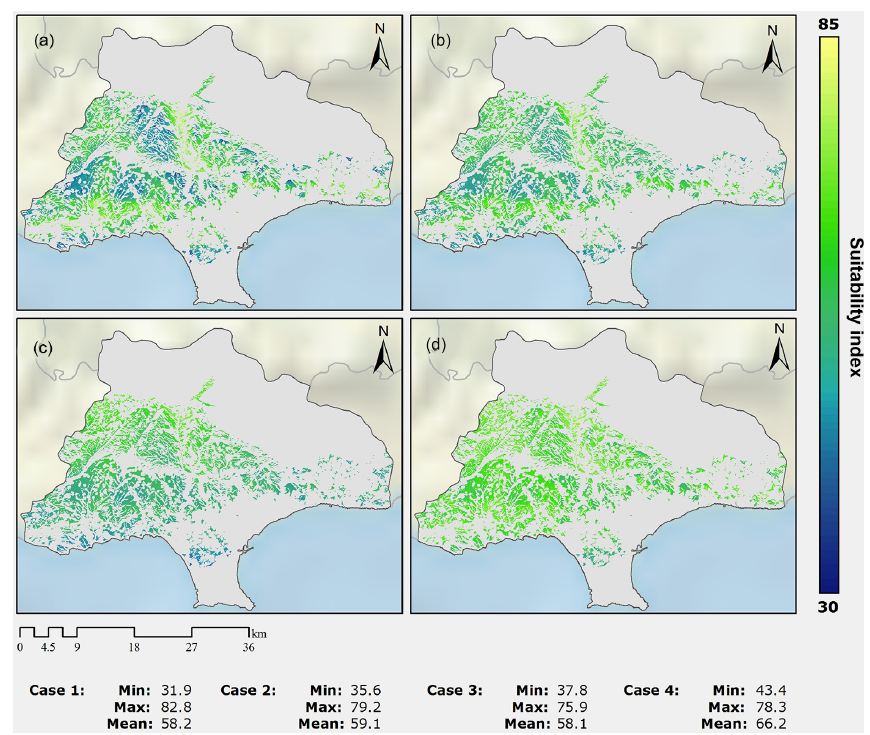
Figure 6. Sensitivity analysis results and comparison among different scenarios, which are not differentiating results: (a) case 1, (b) case 2, (c) case 3, and (d) case